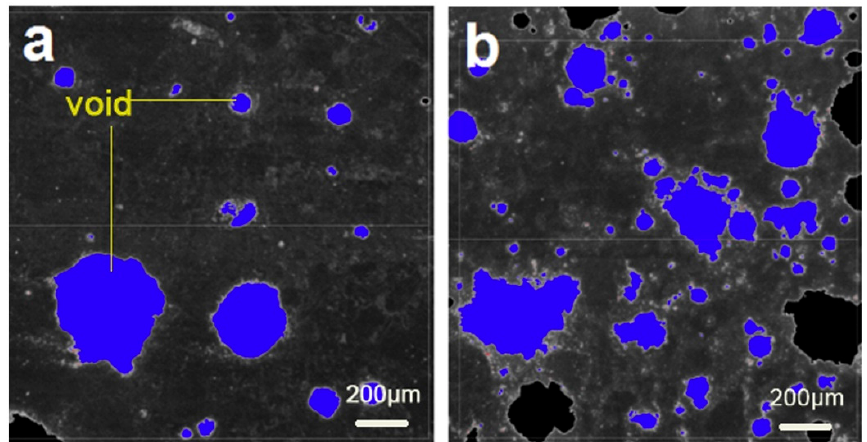
Figure 7. Void images of hardened cement mortar: ( a ) no AEA, ( b ) with AEA.